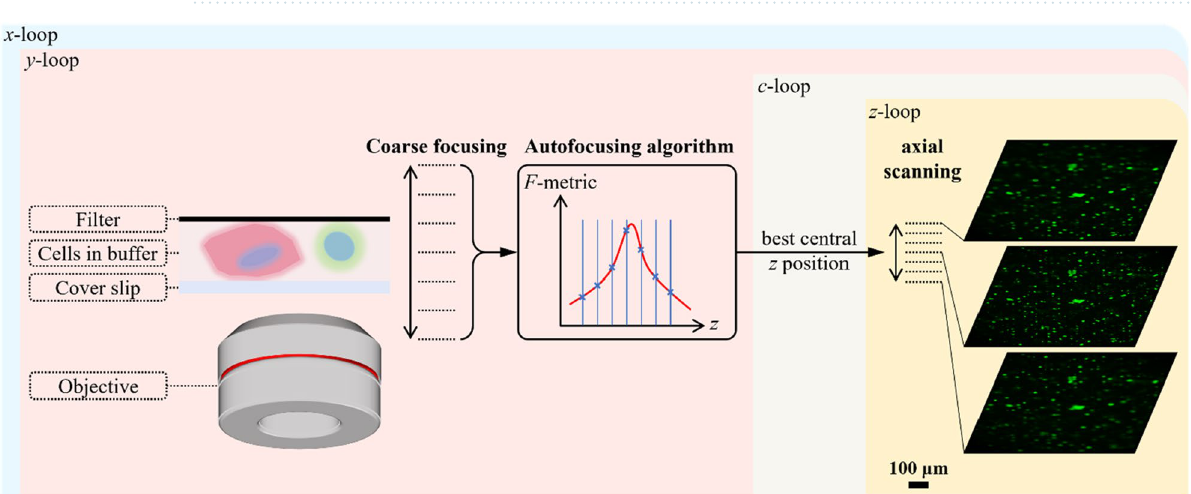
Figure 1. Schematic of overall design. ( a ) Multi-channel epifluorescence microscope imaging system. Since our target cells are distributed on the micro-filter at varied heights, the sample is three-dimensional in nature. They are scanned axially under four channels to fully capture the cell-specific biomarker expression. ( b ) Data preprocessing pipeline. The raw image data are synthesized into a single multi-color all-in-focus whole slide image for further analysis. ( c ) Data analysis. The classical way to detect CTCs and CAFs relies on human experts. ① First, the experienced pathologists review the whole slide, annotate cells of interest, and count their number. ② Then this annotation paired with fluorescence images is used to train a deep learning model. Because of inherent human observer bias in calling or ignoring positive cells, the prediction from the pre- trained deep learning model is used to cross-validate human expert annotation. ③ Finally, the well-trained deep learning model can independently conduct the cell detection and analysis task.